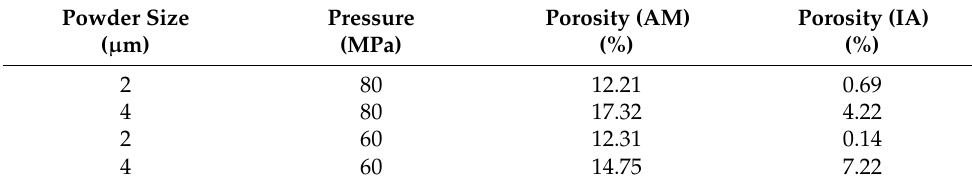
Table 1. Effect of sintering pressure on porosity (at 1600 °C).